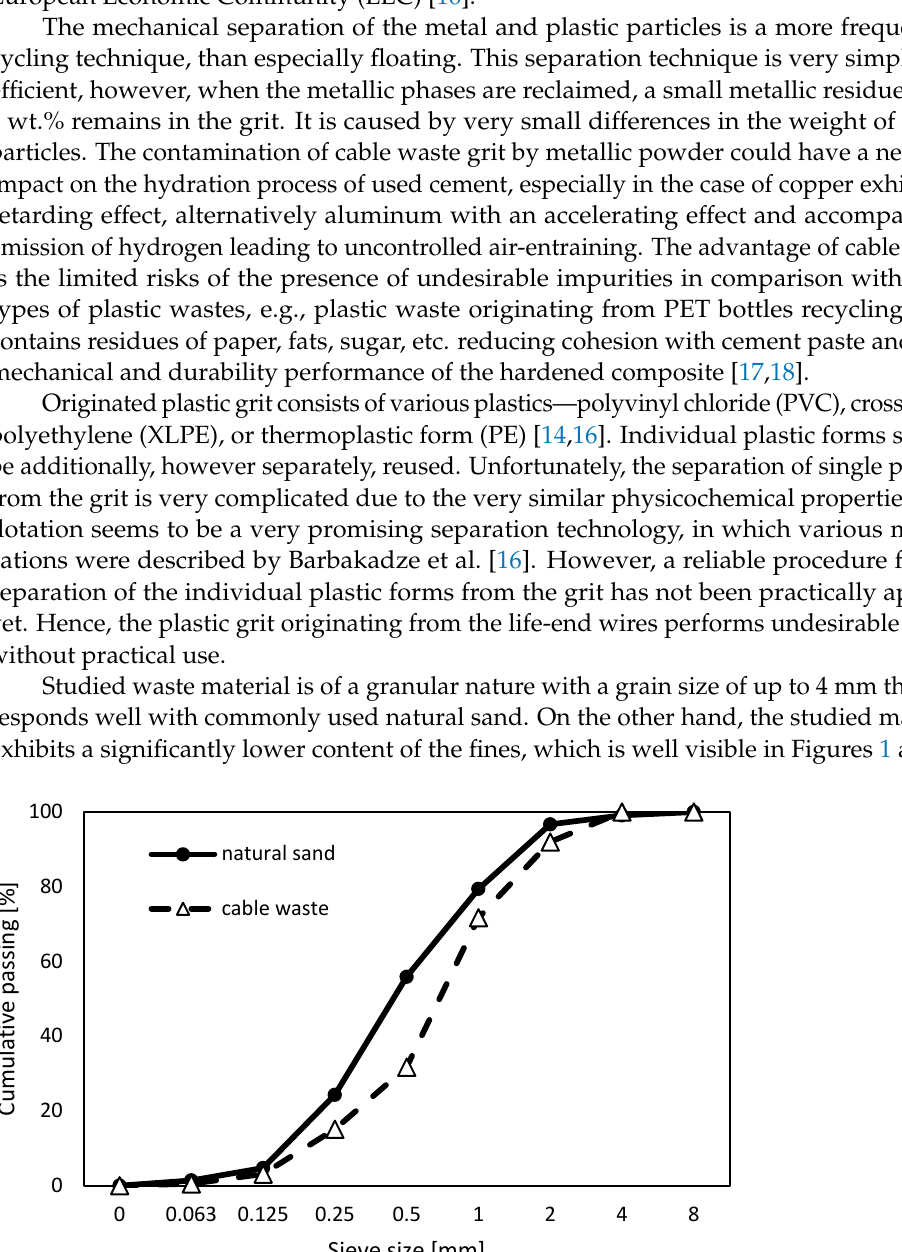
Figure 2. Studied cable waste. The low wettability is a specific property of contained plastics, which causes the fix- ation of air bubbles when they are immersed in water, especially in the form of grit. The present work partially follows previous work [19], which was focused on the air-entrain- ing effect of rubber particles on fresh concrete and on final resistance to freezing–thawing. The present work is focused on the replacement of natural sand, non-renewable material, by waste plastic grit, which originates as a residue after the recycling of life-end wires. Previous research was predominantly focused on the determination of basic physical, me- chanical, and thermal properties of final composites [20,21]. Záleská et al. (2018) also stud- ied the hydrothermal properties of development lightweight composites [22], which was motivated by the reduction of the bulk density of the final composites [23]. However, re- sponse to freezing–thawing of cement-based composites incorporating this waste material has not been studied yet. This program is motivated by the reduced permeability of the concrete, reported by Zéhil and Assad [24], which is caused by the repellent nature of plastic particles.